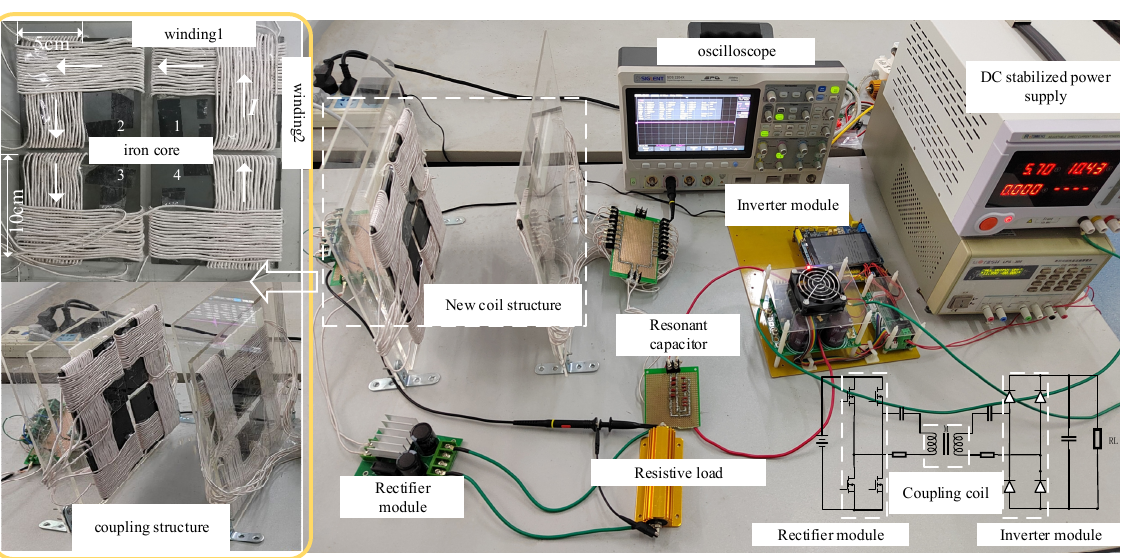
Figure 12. Relationship between mutual inductance and core thickness when facing each other.